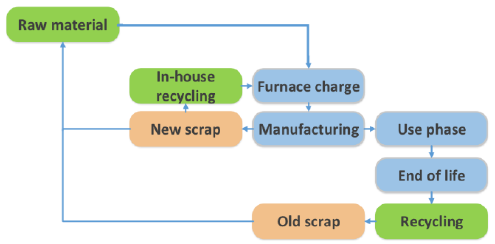
Figure 12. Material flow diagram of the recycling.